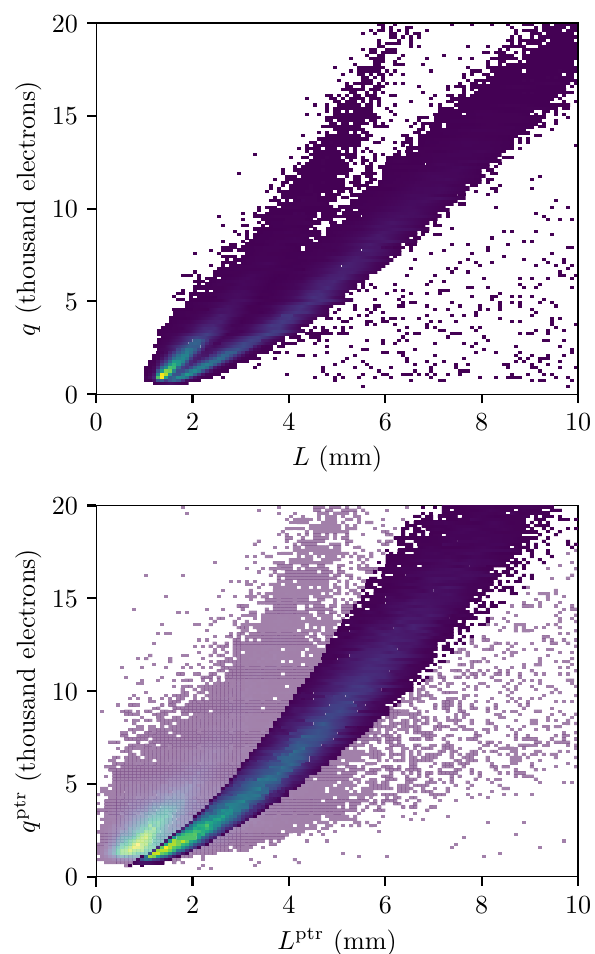
Fig. 20 2D histograms of L vs. q for the benchmark method (top) and for ptr (bottom), using the beam-on sample. In both plots, the bottom band corresponds to alpha nucleus recoils, while the top band corresponds to C/O nucleus recoils. For ptr , the partially transparent events fall outside of a selection on the floating smeared Bragg scale factor 0 . 6 < s < 1 .